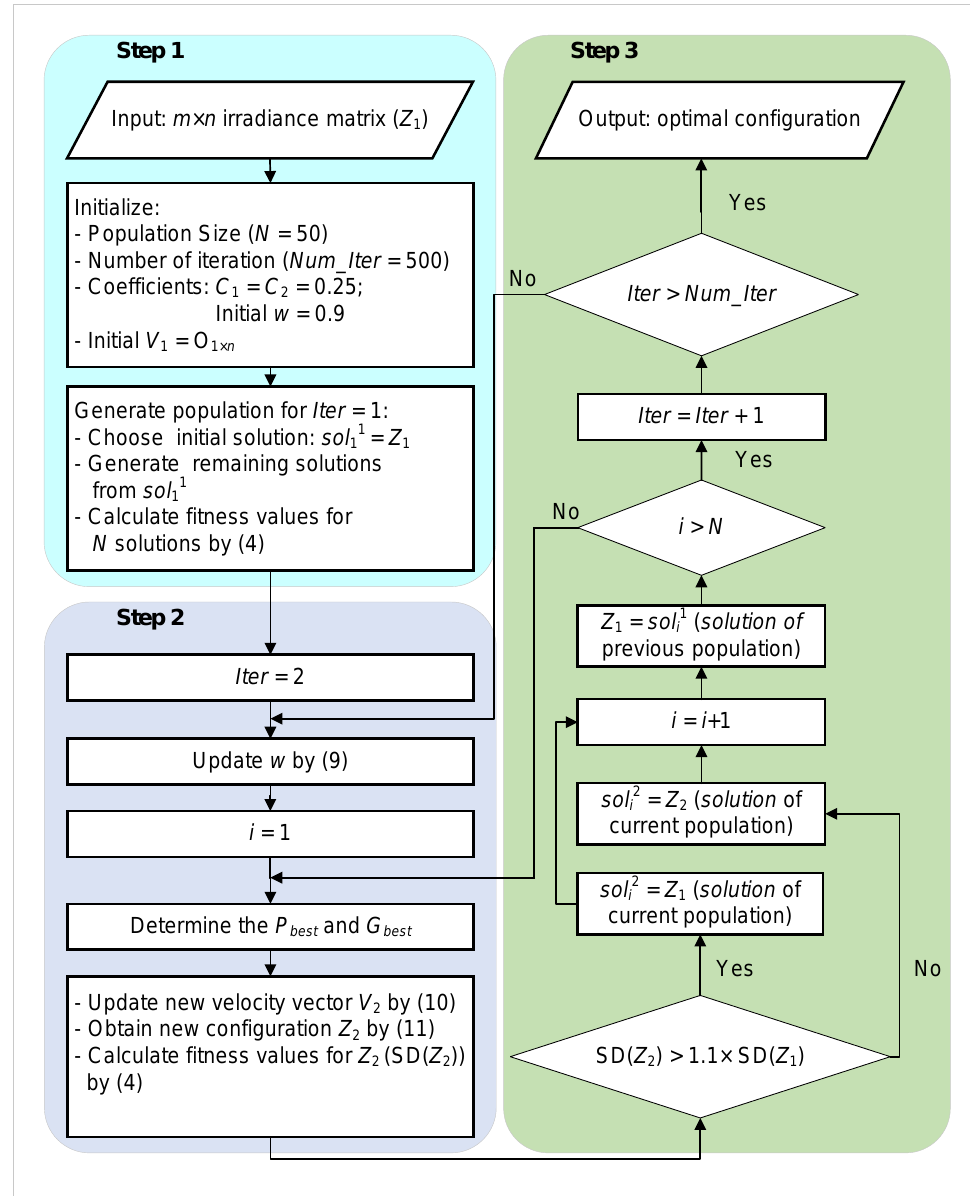
Figure 7. Flowchart of proposed PSO-based